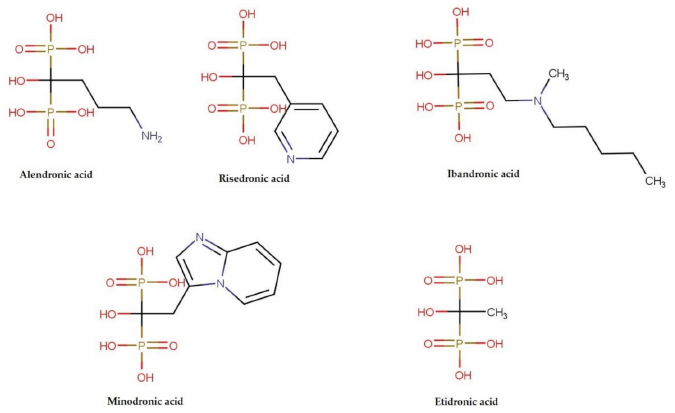
Figure 2. Chemical structures of bisphosphonates discussed in the